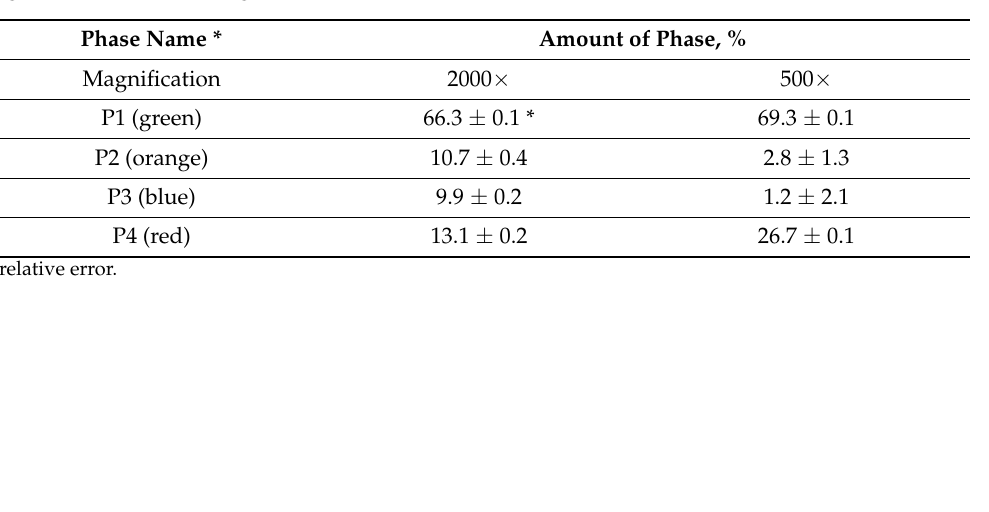
Table 4. Percentage distribution of analyzed phases P1, P2, P3, and P4 in the image, corresponding to Figure 15l (2000 × ) and Figure 17 (500 ×